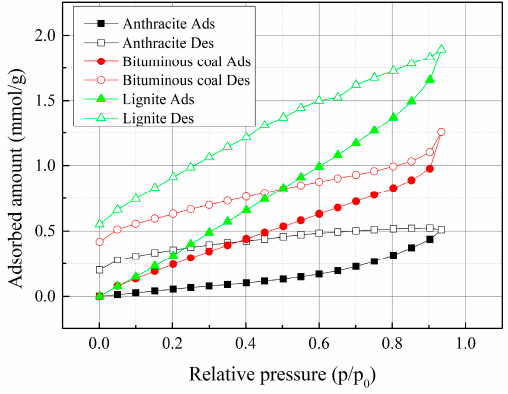
Figure 8. Water adsorption-desorption isotherms for the samples at 298 K.